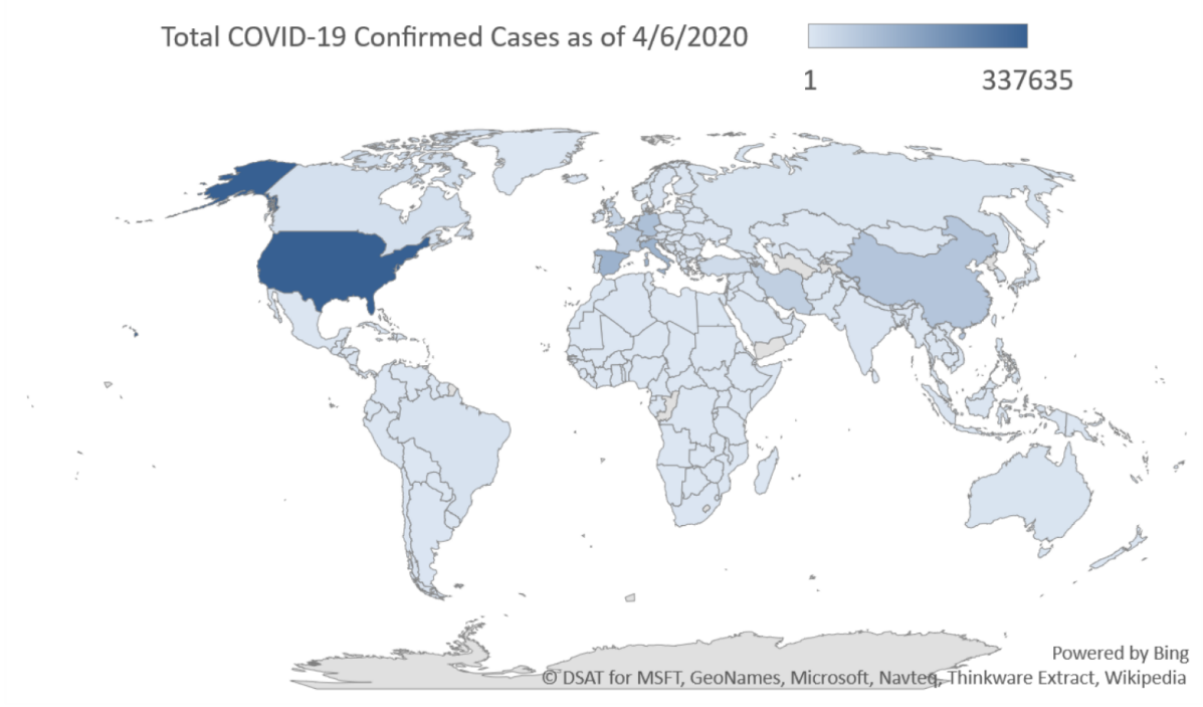
Figure 3. Geographic heat map of worldwide real-world confirmed cases of COVID-19 as of April 6, 2020. COVID-19: coronavirus